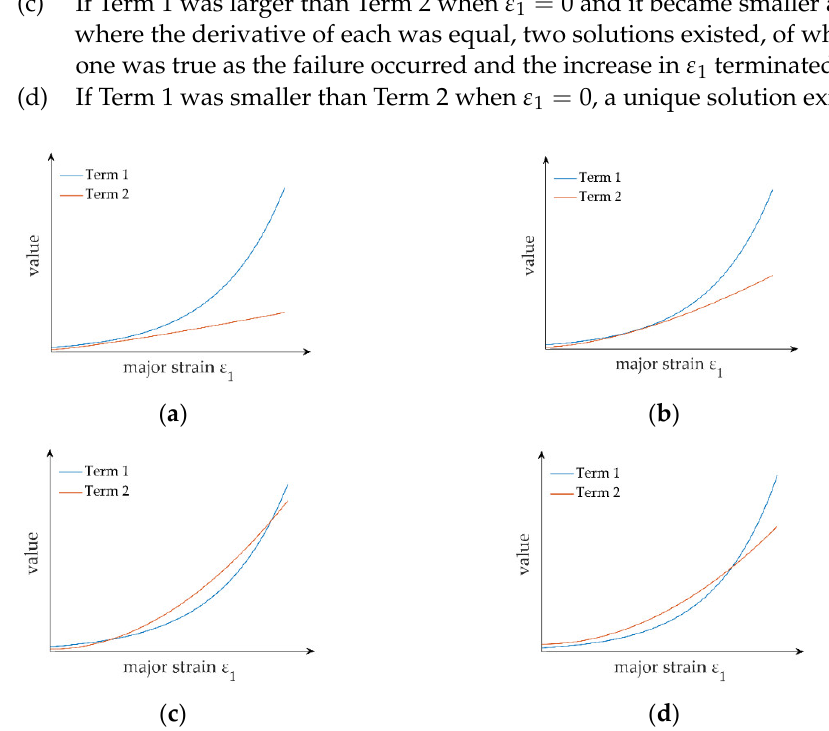
1  , while the term on the right side (Term 2) increased polynomi- ally. This indicated that Term 1 increased at a higher rate than that of Term 2 after a given point, where the derivative of each side was equal. Thus, there were four bifurcation con-